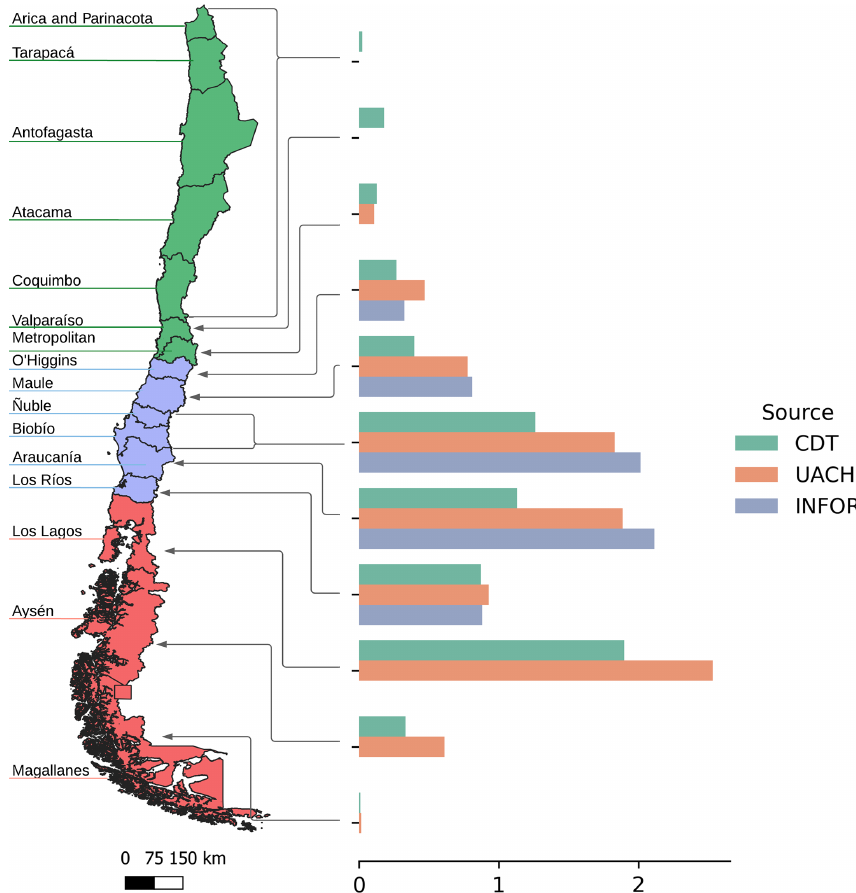
Figure 2. Annual fuelwood consumption in kilotons for 2017 by region according to UACH (2013, red), CDT (2015, green) and INFOR (2019, blue). Regions are colored according to the data source used in each